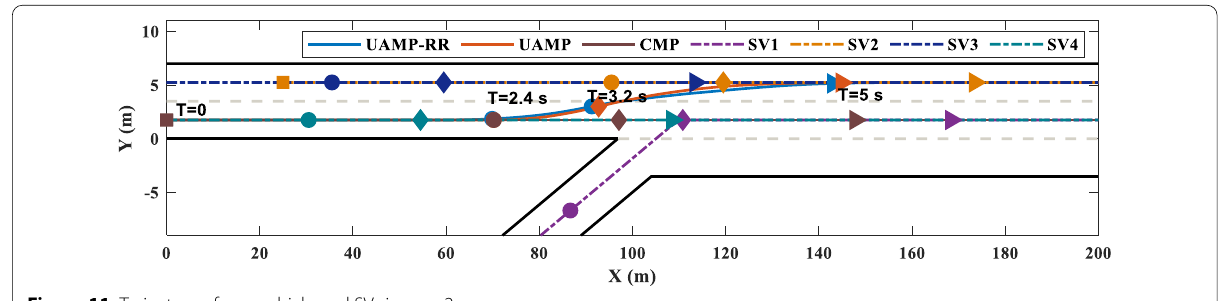
Figure 11 Trajectory of ego vehicle and SVs in case